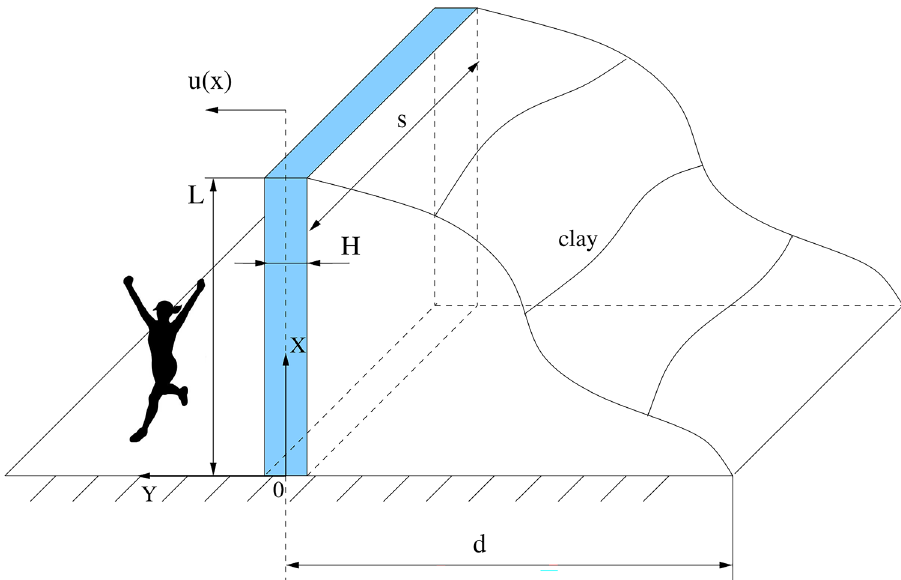
Figure 1. Retaining wall based on the non-quaking